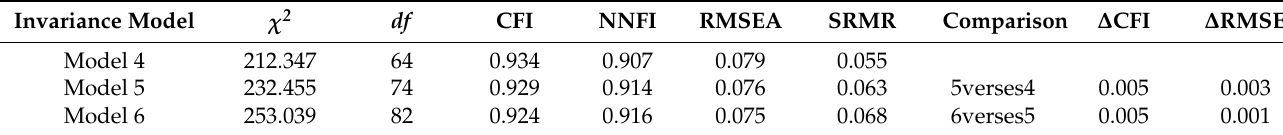
Table 2. Measurement invariance across